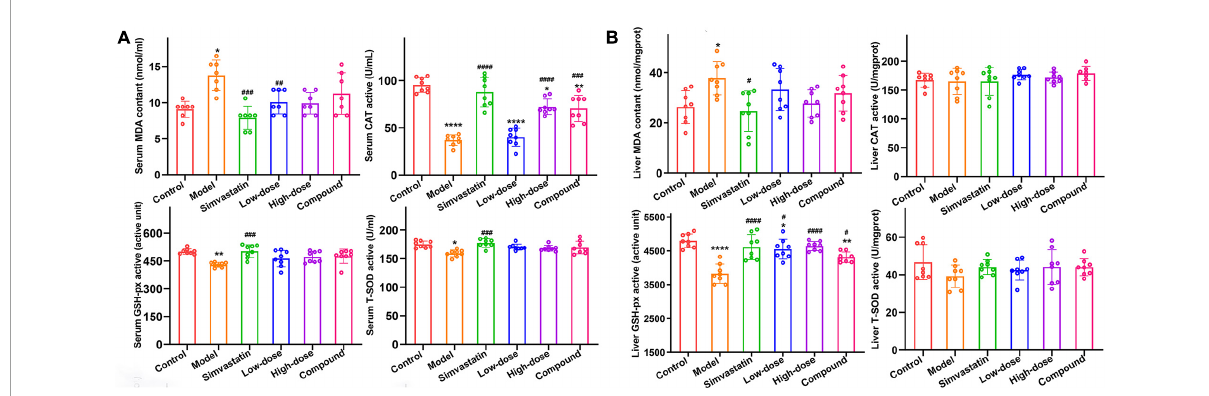
FIGURE5 The effect of HFA on MDA and antioxidant enzymes in serum and liver of hyperlipidemia rats. (A,B) MDA, CAT, GSH-px and SOD levels in serum and liver, respectively. Data represent mean ± SD ( n = 8). Statistically significant results were indicated as * p < 0.05, ** p < 0.01, *** p < 0.001, and **** p < 0.0001 vs. control group; # p < 0.05, ## p < 0.01, ### p < 0.001, and #### p < 0.0001 vs. model group.